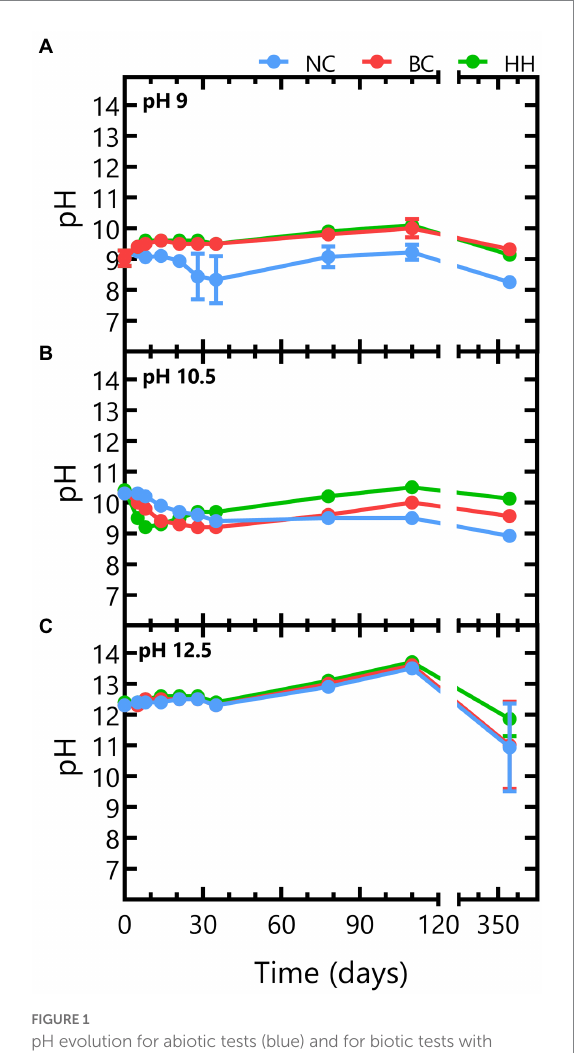
FIGURE 1 pH evolution for abiotic tests (blue) and for biotic tests with Boom Clay borehole water (red) and Harpur Hill sediment (green) in conditions with initial (A) pH 9, (B) pH 10.5, and (C) 12.5. Results are presented as the average and standard deviation of three replicates, except for day 356 and abiotic samples of pH 9 and 10.5 where the result of two replicates is